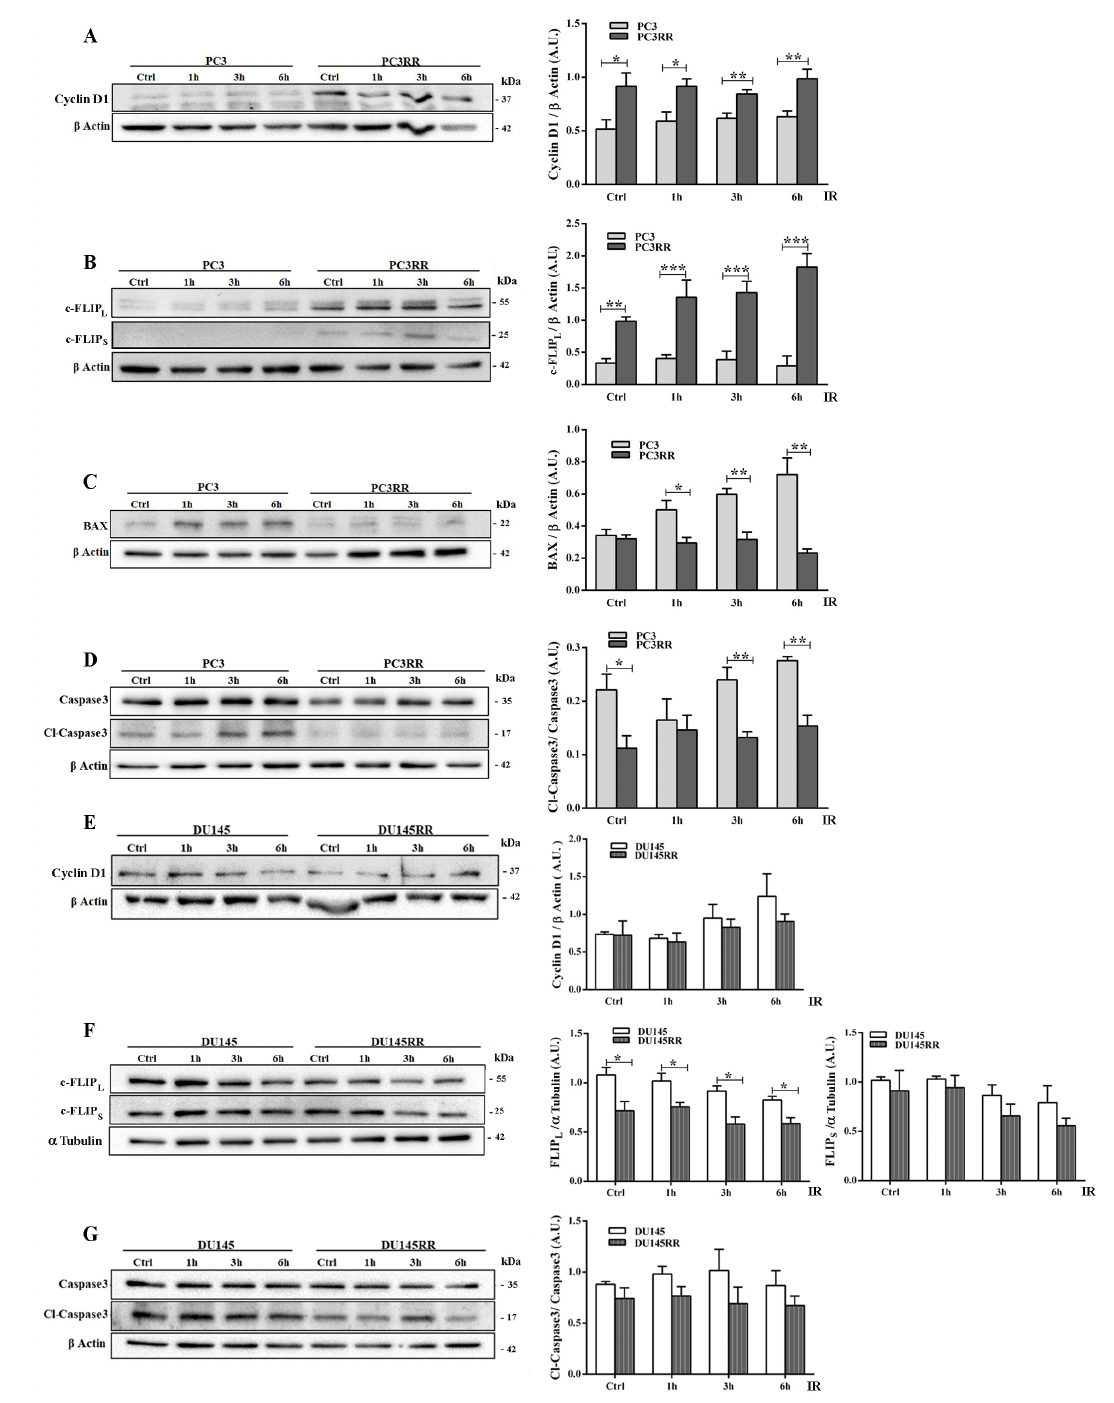
Figure 4. Effect of radiation on proliferation and on apoptotic cell markers in PC3RR and DU-145RR cells compared to their parental counterparts. Cell lysates from untreated or cells treated with 4 Gy were collected at 1, 3 and 6 h after IR. Using Western blots, we analysed the expression of Cyclin D1 ( A , E ), c-FLIP L and c-FLIP S ( B , F ), BAX ( C ), Caspase 3 and Cl-Caspase 3 ( D , G ). β -Actin was used as a control for equal amounts of loaded proteins. Densitometric analysis has been performed on at least three separate Western blots, and the histograms represent the mean ± S.E.M. evaluated as arbitrary units (A.U.). Statistical significance: * p <0.05, ** p <0.01, *** p <0.001; PC3RR vs. PC3 and DU-145RR vs. DU-145 Student’s unpaired t